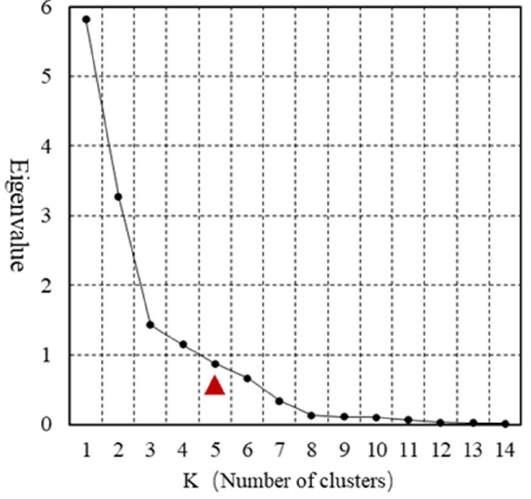
Figure 8. Scree Figure 8. Scree plot.